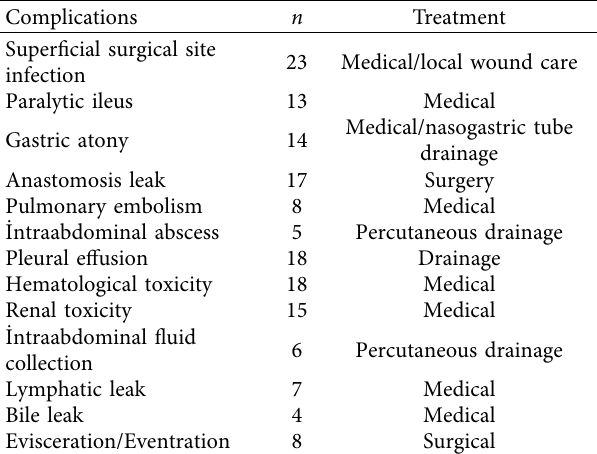
Table 4: Postoperative